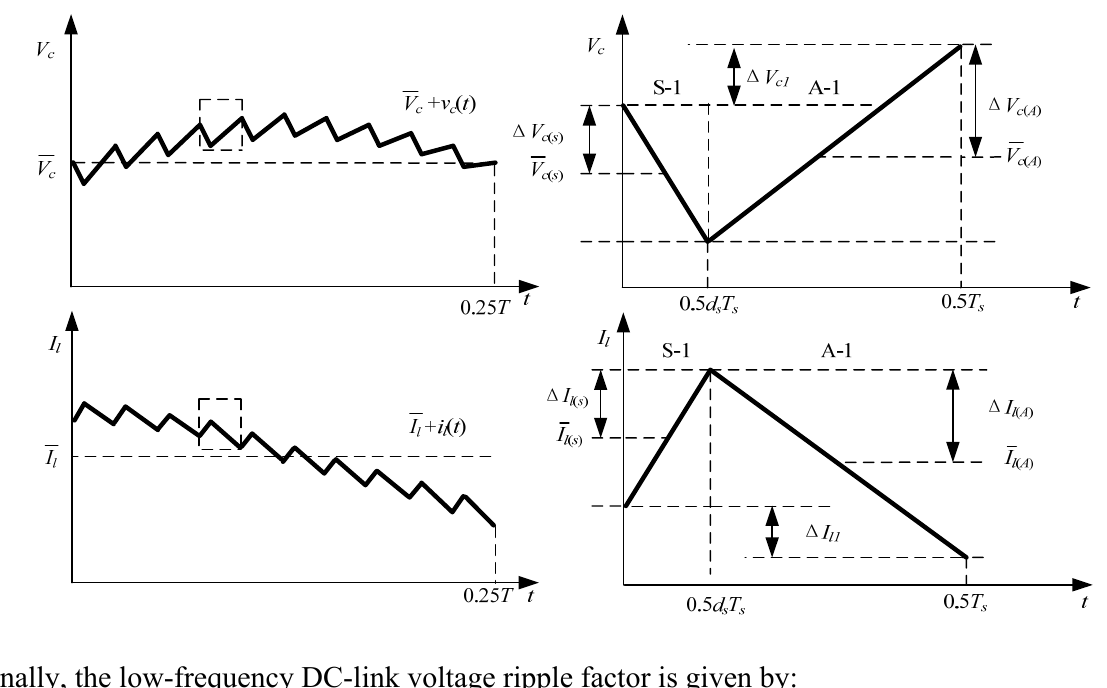
Figure 5. Waveforms of capacitor voltage and inductor current for low-frequency ripple